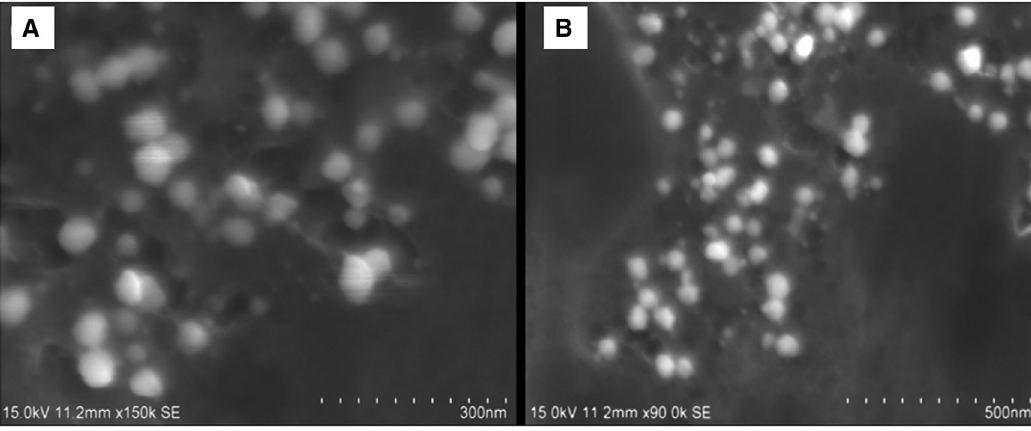
Figure 7 Scanning electron microscopy (SEM) images of PEGylated gold